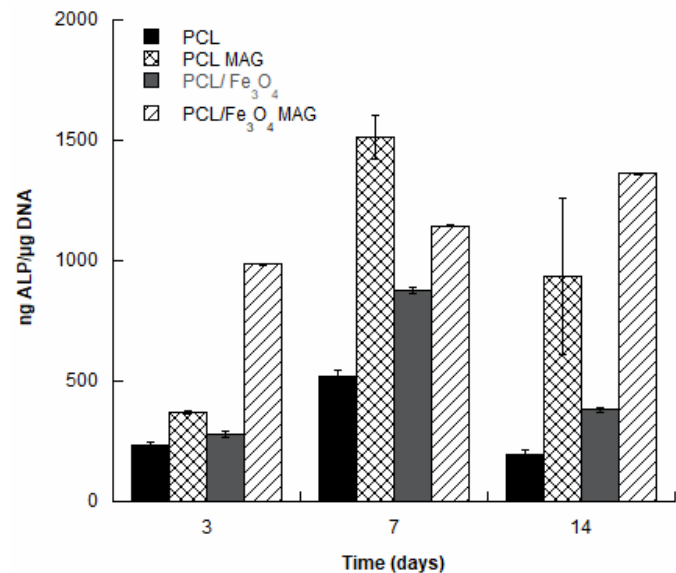
Figure 4. Normalized alkaline phosphatase (ALP) activity (ALP/DNA) for PCL, PCL/Fe ₃ O ₄ , PCL Mag, and PCL/Fe ₃ O ₄ Mag at 3, 7, and 14 days after cell seeding.